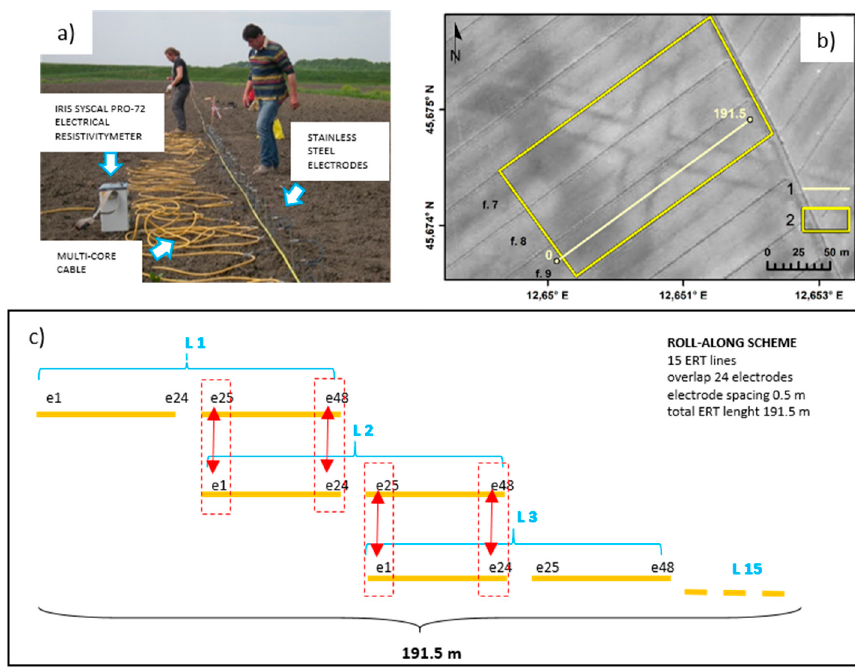
Figure 6. Geophysical measurements: ( a ) Image of an ERT line acquisition; ( b ) Localization of geophysical measurements: blue line (1) ERT, yellow area (2) FDEM; ( c ) scheme of ERT acquisition.